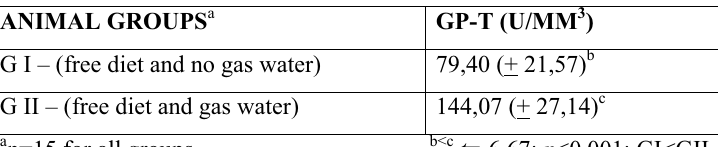
international unities by blood cubic millimeters (U/mm3) and respective standard deviations, in the experimental groups